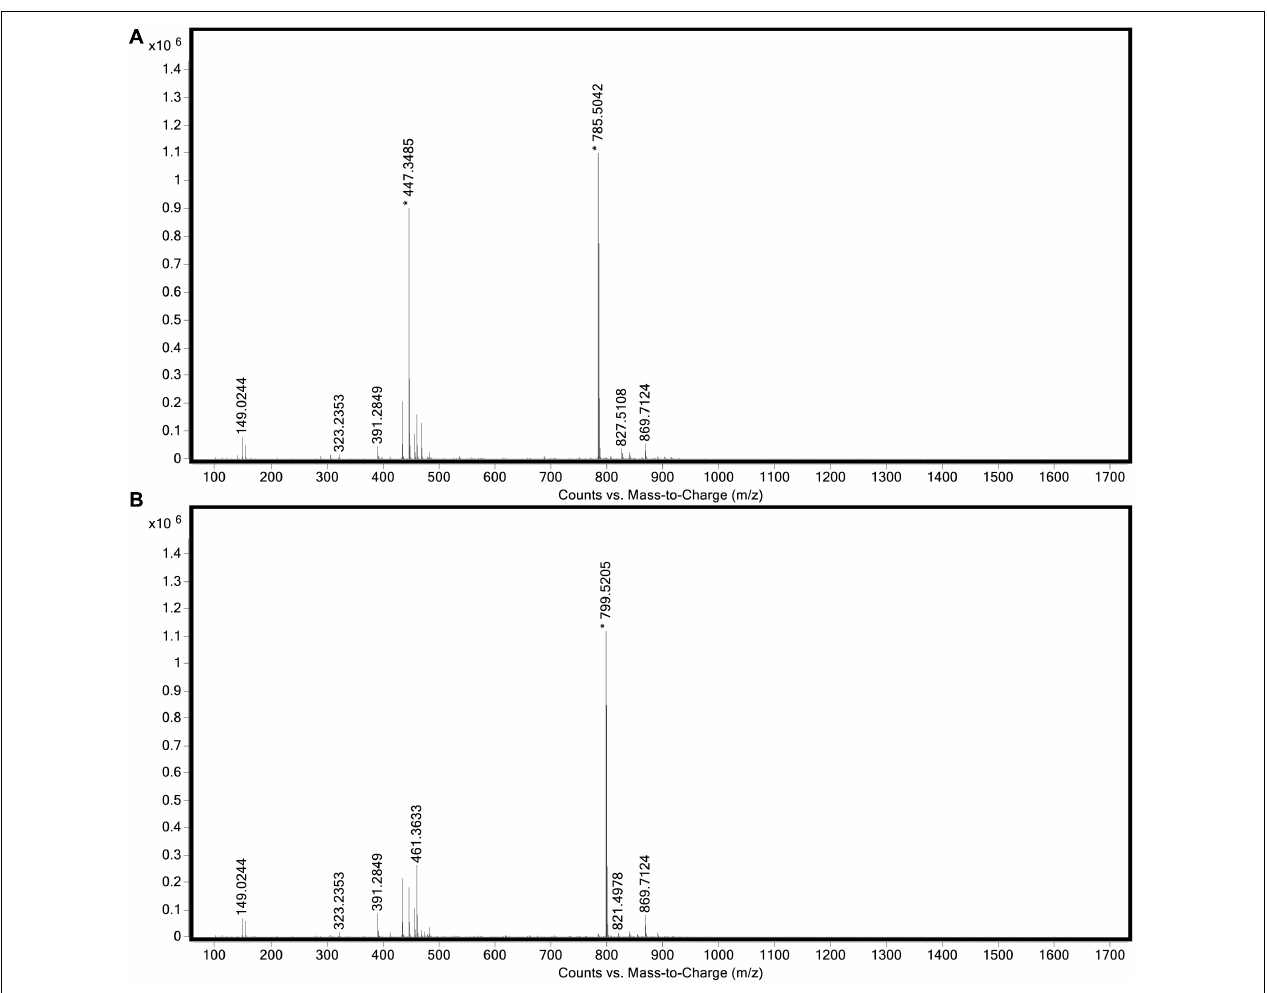
FIGURE 7 | Full mass spectra of (A) peak c 1 and (B) peak c 2 obtained during LC/MS analysis of the extract from “ Ca. C. masyuteum.”